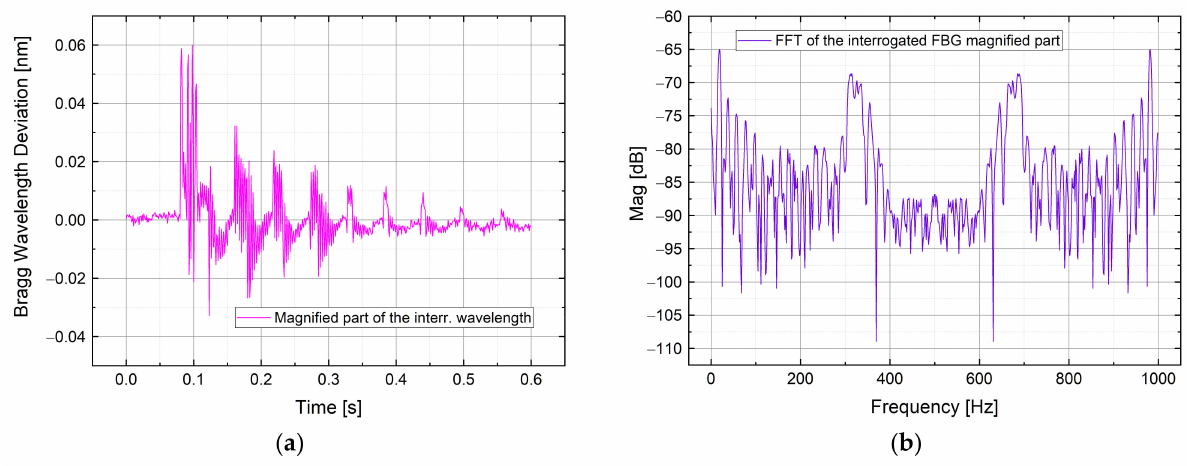
Figure 11. Bragg wavelength deviation interrogated during a strain measurement ( a ), with the relative FFT ( b